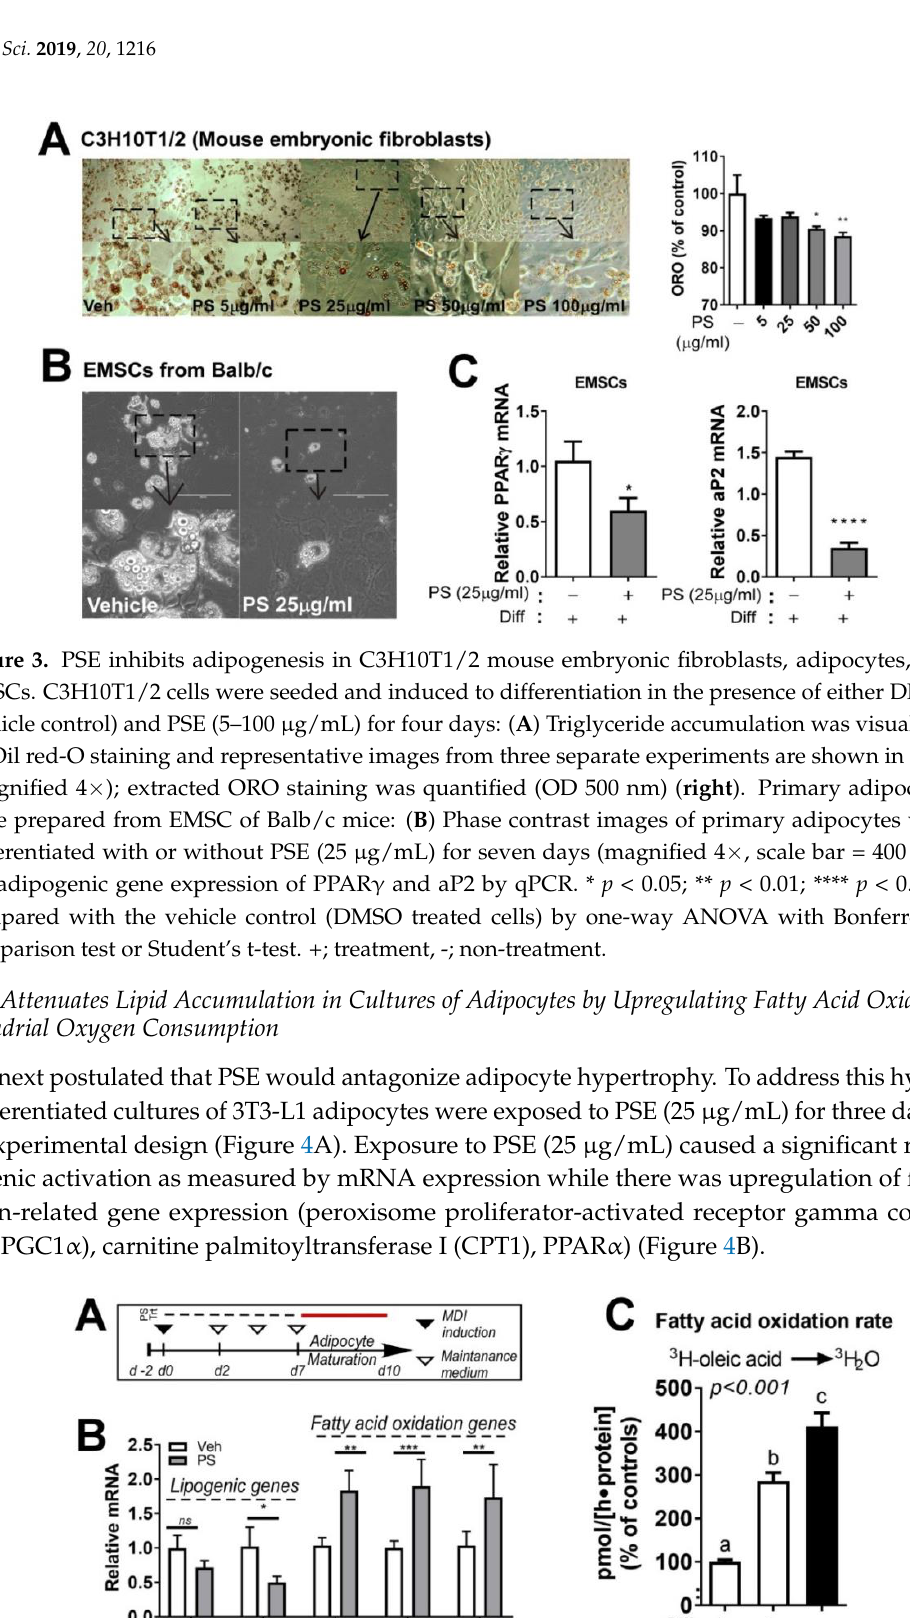
Figure 4. PSE attenuates lipid accumulation in cultures of adipocytes by upregulating fatty acid oxidation and mitochondrial oxygen consumption. ( A ) Experimental scheme. 3T3-L1 were seeded on the second day before differentiation ( d‒2 ) and induced to differentiation ( d0, MDI: methyl isobutyl- xanthine, dexamethasone, and insulin). Keep 3T3-L1 cells differentiated into fully differentiated adipocytes until d7. Fully differentiated adipocytes ( d7 ) were incubated with PSE (25 μg/mL) for three days. ( B ) Lipogenic and fatty acid oxidation-related gene expression of PPARγ, aP2, PGC1α, CPT1, and PPARα as determined by qPCR. ( C ) Conversion of [ 3 H]-OA into [ 3 H]-H 2 O. ( D ‒ F ) Oxygen consumption rate (OCR) in 3T3-L1 adipocytes treated with Veh (blue) and PSE (red) as determined by Seahorse extracellular analyzer. 3T3-L1 cells differentiated into fully differentiated adipocytes. Fully differentiated adipocytes ( d7 ) were incubated with PSE (25 μg/mL) for one day. Arrow indicates the addition of respiratory inhibitors of oligomycin (Oligo), carbonyl cyanide 4-trifluoromethoxy phenylhydrazone (FCCP) and a combination of antimycin A and rotenone